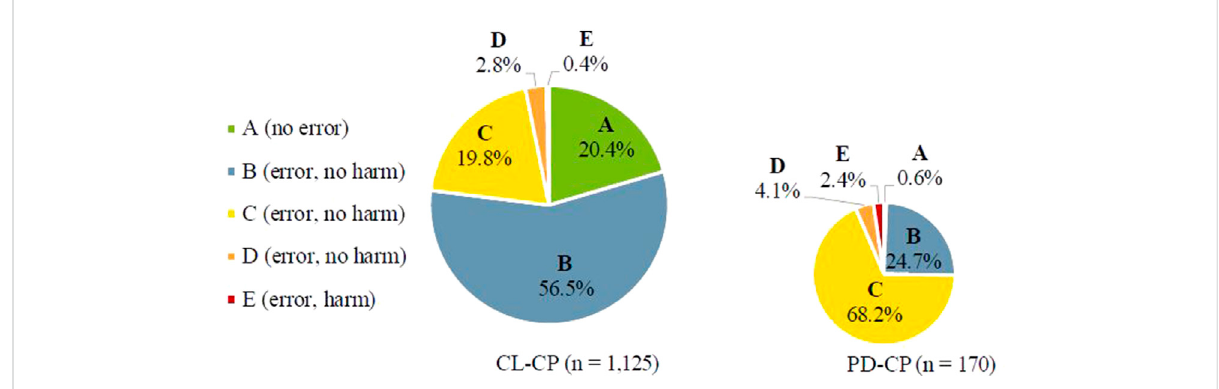
FIGURE 2 Classi fi cation of medication errors according to NCC MERP considering the number of PIs within the two groups of CPs. ( Category A : Circumstances or events that have thecapacity to cause error. Category B : An error occurred, but theerror didnot reachthe patient. Category C :An error occurred that reached thepatient, but didnot cause patient harm. Category D : Anerror occurredthat reached thepatient and required monitoring to con fi rm that it resulted in no harm to the patient and/or required intervention to preclude harm. Category E : An error occurred that may have contributed to or resulted in temporary harm to the patient and required intervention. Category F : An error occurred that mayhavecontributedtoorresultedintemporaryharmtothepatientandrequiredinitialorprolongedhospitalization. CategoryG :Anerroroccurred that may have contributed to or resulted in permanent patient harm. Category H : An error occurred that required intervention necessary to sustain life. Category I : An error occurred that may have contributed to or resulted in the patient ’ s